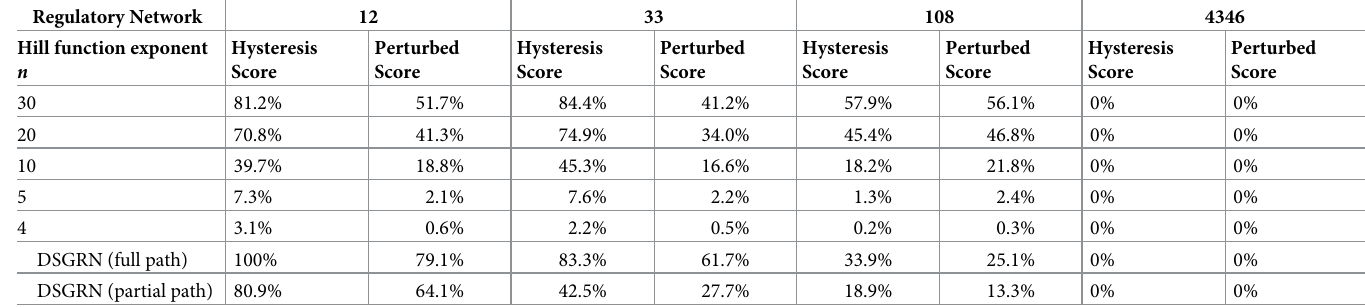
Table 2. (Hysteresis and perturbed hysteresis scores) Results for comparisons with four networks. Numbers for Regulatory network come from ranking in Fig 8. Bot- tom rows are the full and partial path hysteresis scores obtained from DSGRN for Regulatory networks 12, 33, 108, and 4346. The first column indicates the exponent of the Hill function used in the ODE model for the regulatory network. The two columns under each regulatory network number indicate the percentage of continuation computations that result in a hysteresis curve. The first column assumes the parameter value is in a region defined by v the parameter value is in region defined by a one edge neighborhood. 1000 curves were computed for each